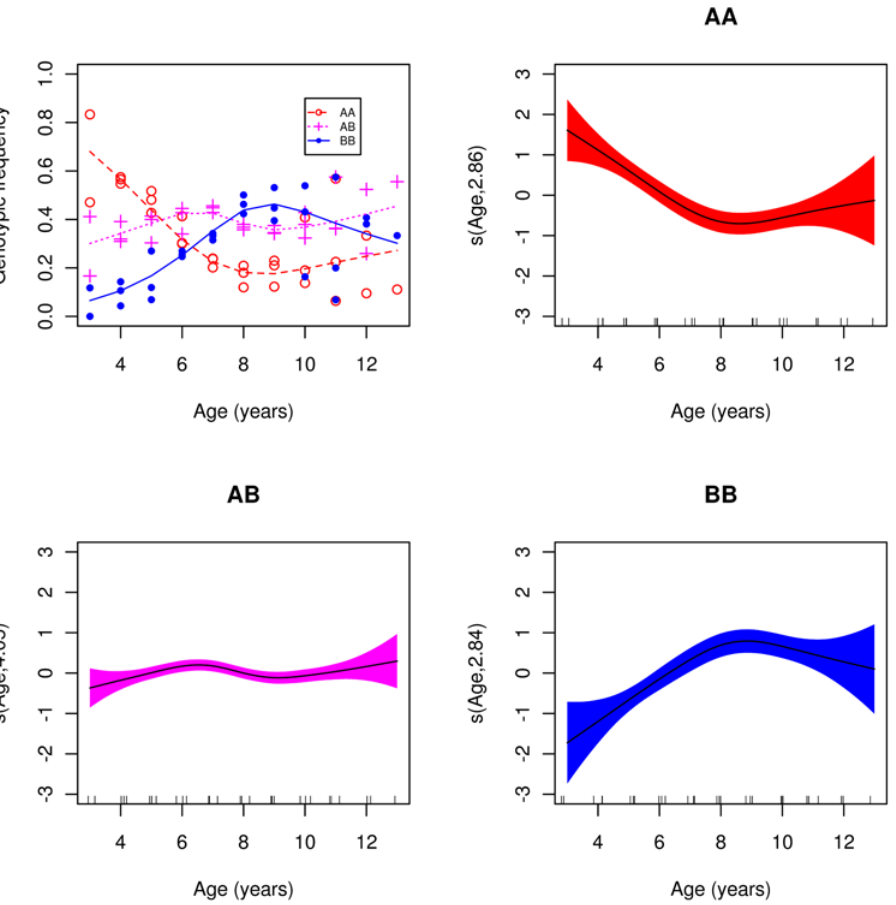
Figure 6. Genotypic frequencies on age in years within year class. Frequencies of AA genotype (red open circles # , dashed line), AB (magenta pluses + , dotted line), and BB (blue filled circles N , solid line). Lines represent a generalized additive model (gam) smooth fit with quasibinomial link (panel A). Panels B, C and D: gam smooth fit of genotypic frequency on age within year class for the AA , AB and BB genotypes respectively; shaded region represents two standard errors above and below fit. Smooth carries estimated degrees of freedom.